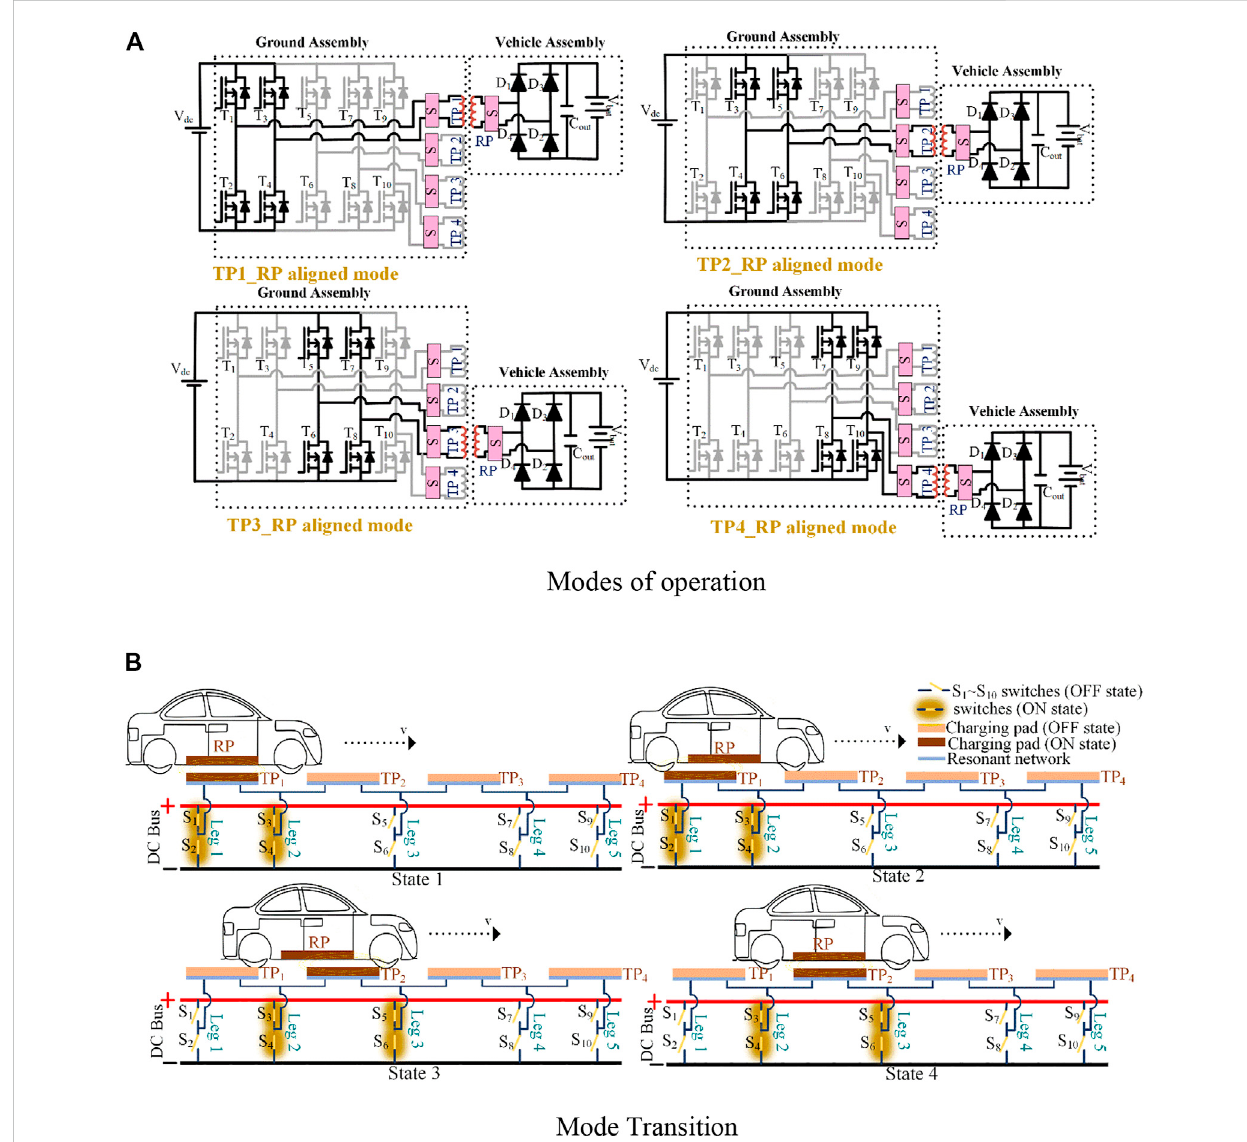
FIGURE 5 Modes of operation of a fi ve-leg inverter. (A) Modes of operation, (B) Mode